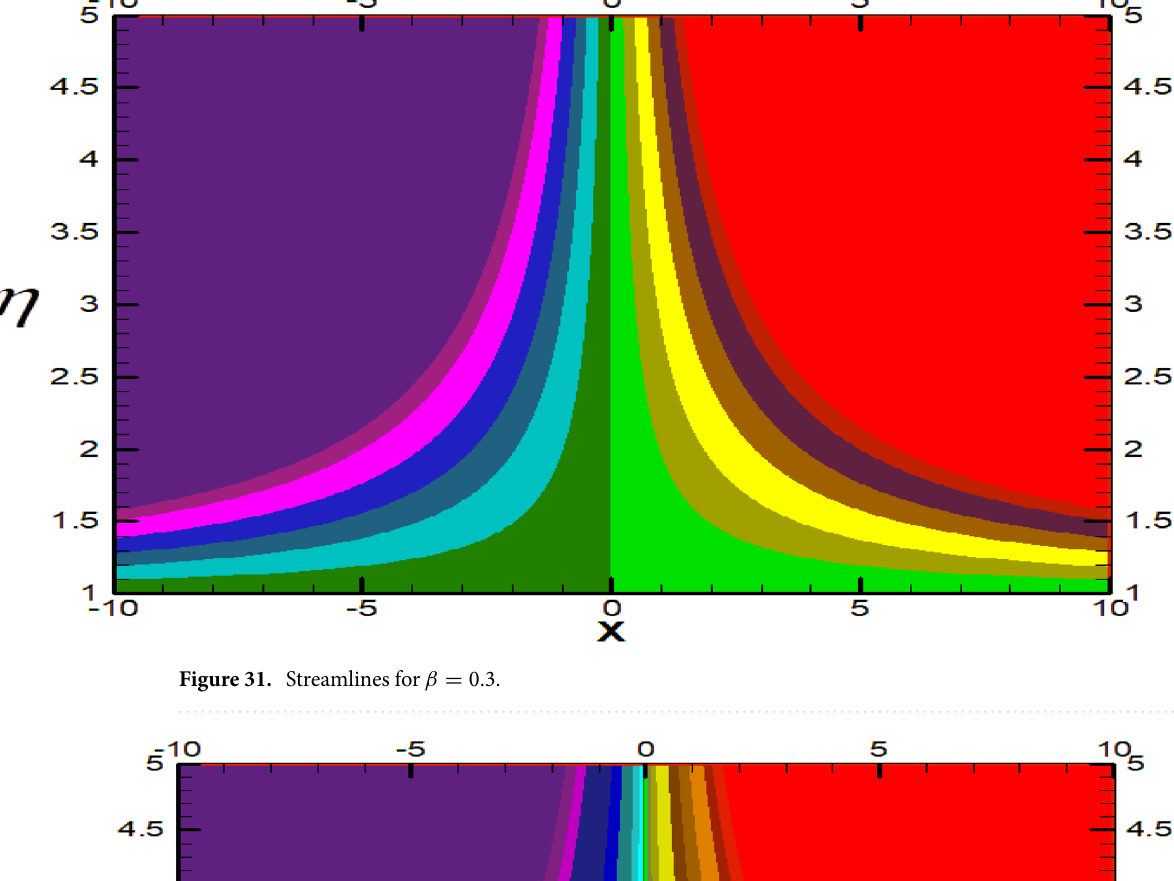
Figure 31. Streamlines for β